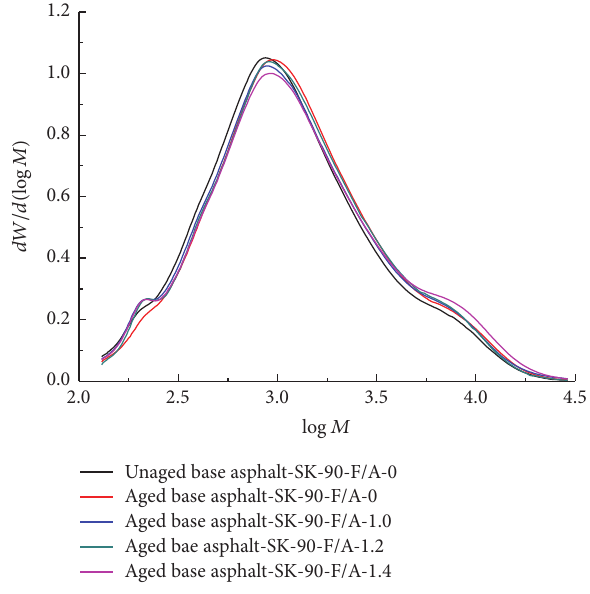
Figure 8: The molecular weight distribution of asphalt